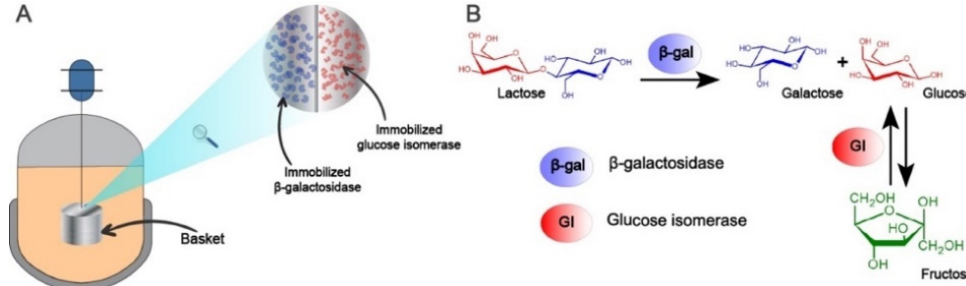
Figure 1. ( A ) Schematic representation of a spinning basket reactor with separate compartments for each immobilized biocatalyst. ( B ) Scheme of lactose hydrolysis with β -gal and glucose isomerization with GI.